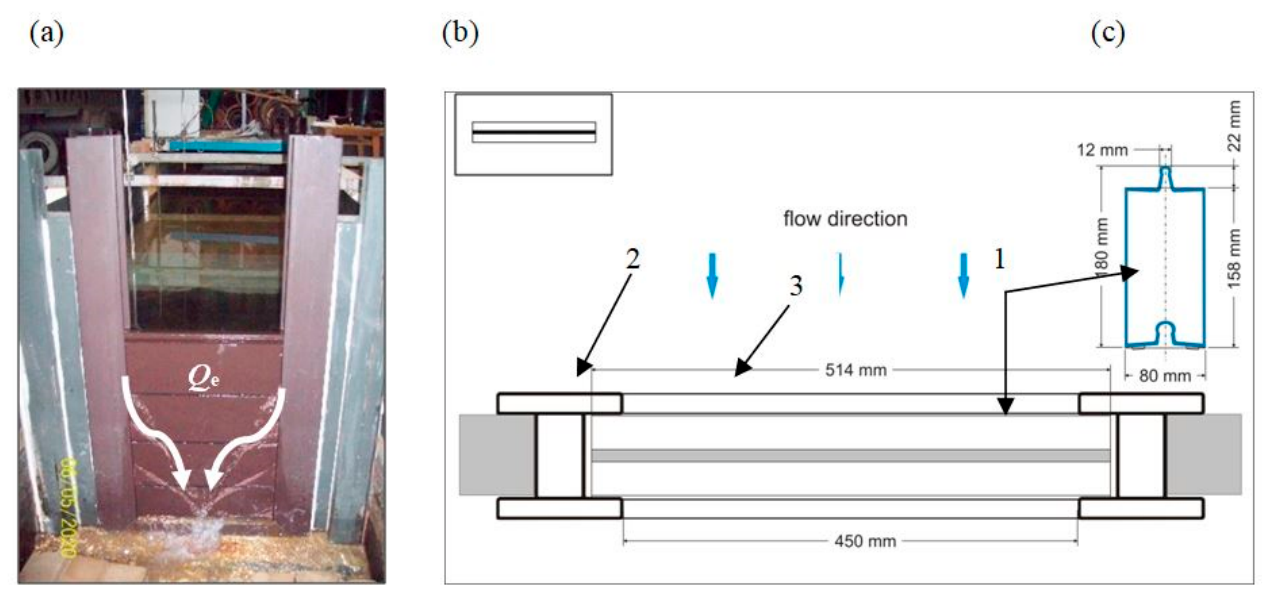
Figure 3. Measurement scheme of the S rectilinear regulator ( a ) measuring station, ( b ) regulator mounting, ( c ) cross-section of the beam: 1—beam; 2—gib; 3—regulator sill (photo by J. Urba ń ski). The labyrinth regulator U (8b in Figure 2, Figure 4) consisted of beams (1 in Figure 4) and two gibs: one with a female lock (2 in Figure 4) and the other with a male lock (3 in Figure 4). In the tested model with an opening width b = 0.588 m, the height P of the overflow edge position could be adjusted within the range of 0.0 ÷ 102.2 cm relative to the bottom (Table 1) by inserting or removing beam elements. Figure 4. Measurement diagram of the U labyrinth regulator: ( a ) measuring station, ( b ) regulator mounting, ( c ) cross-section of the beam: 1—beam; 2—gib with female lock; 3—gib with a male lock (photo by Z. Popek). The compound regulator Z (8c in Figure 2, Figure 5) was composed of two asym- metrical elements (1 in Figure 5) connected with each other by a lock in a vertical line. In the test specimen with an opening width b = 0.545 m, the height P could be adjusted within